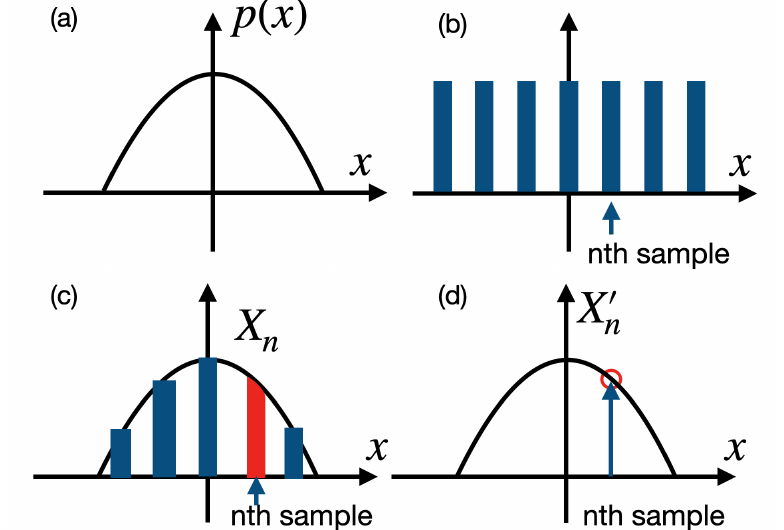
Figure 2. An brief illustration for the sampling effect. Consider a one-dimensional photon density distribution along the x-axis whose profile is noted as p ( x ) in ( a ). Suppose we sample the profile with an integral sampling array marked with the blue blocks in ( b ). The nth sample X n differs from the nth impulse sample X (cid:48) n by a slight deviation since X n is the red area below the profile (shown in ( c )) while X (cid:48) n stands for the exact value of p ( x ) at the nth sampling point (shown in ( d )). X n and X (cid:48) n are usually unequal for an arbitrary photon density